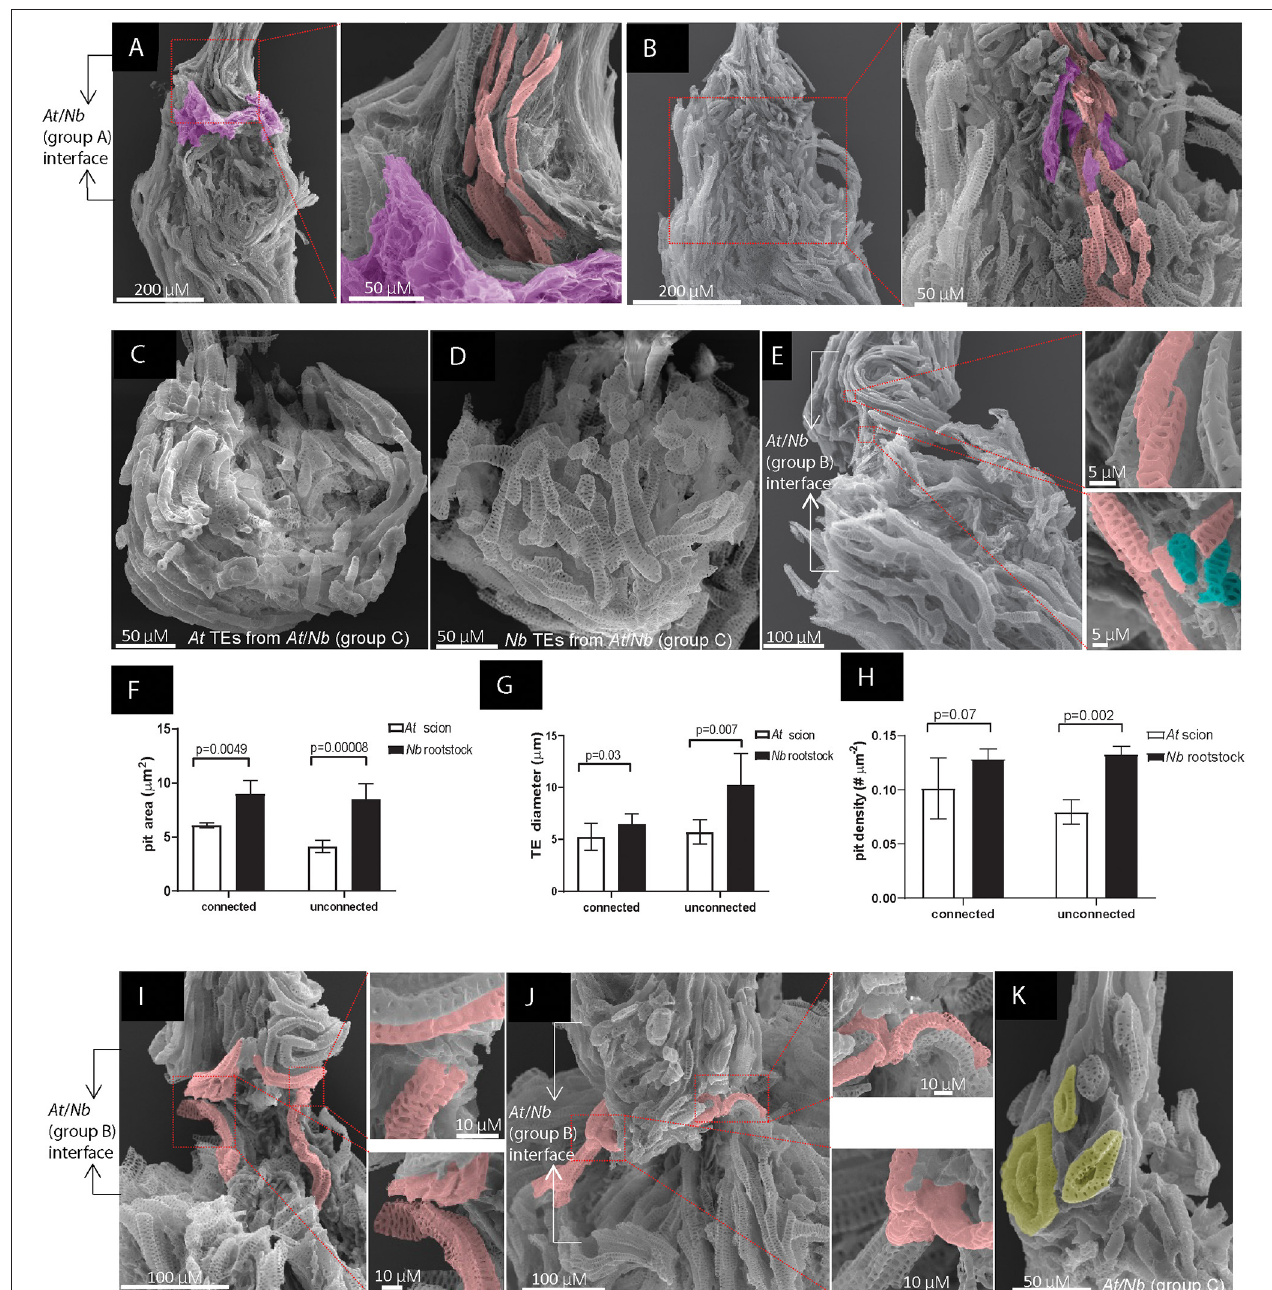
FIGURE 4 | TE overlapping and alignment in At / Nb grafts. (A) TEs at the grafting union of Group A graft washing with 1.2% Triton X-100. Right: the short TEs above the union were overlapping and aligned. (B) The same graft in (A) was washed with 5% Triton X-100 to reveal the grafting interface. Right: the reticulate TEs of At and Nb were overlapping and aligned. (C) The horizontally growing TEs of At at the interface of group C grafts. (D) The horizontally growing TEs of Nb at the interface of group C grafts. (E) The grafting interface in group B grafts. Right top: overlapping of the top end of an Nb TE with an At TE. Right bottom: overlapping of the bottom end of the same Nb TE with other Nb TEs. (F) Comparison of the pit area in the connected ( n = 7) and unconnected TEs at the interface ( n = 9). (G) Comparison of the TE diameter in the connected ( n = 6) and unconnected TEs at the interface ( n = 6). (H) Comparison of the pit density in the connected ( n = 9) and unconnected TEs at the interface ( n = 9). (I) contact of the non-homogenous TEs. Right: the repelling pattern was enlarged. (J) Two patterns formed in the same graft. Right Top: contact of the homogenous TE. Right Bottom: the non-homogenous TEs repelled each other. (K) The circled TEs formed above the grafting interface of group C grafts due to self-fusion. The pink rendering corresponds to the short TEs. The green-blue rendering corresponds to irregular TEs. The magenta rendering corresponds to the cellular deposits. The yellow rendering corresponds to the self-fused TEs. Data in (F–H) were shown as the mean ± SD. p- value was calculated by Student’s T -test.